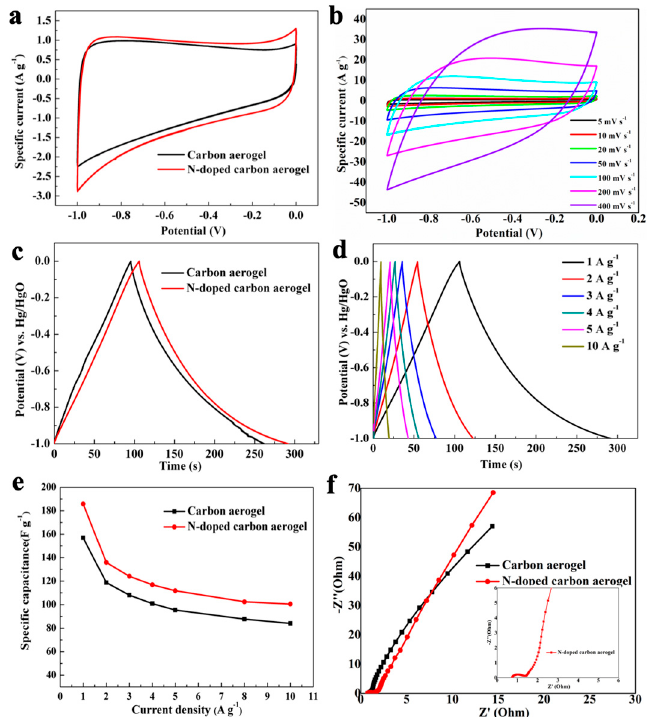
Figure 5. Electrochemical capacitive behaviors of the carbon aerogel and N-doped carbon aerogel. ( a ) CV curves at a scan of 10 mV s − 1 (6 M KOH); ( b ) CV curves of the N-doped carbon aerogel at different scan rates; ( c ) galvanostatic charge/discharge curves of the carbon aerogel and N-doped carbon aerogel at 1 A g − 1 ; ( d ) galvanostatic charge/discharge curves of the N-doped carbon aerogel with different current densities; ( e ) specific capacitances of the carbon aerogel and N-doped carbon aerogel at different current densities; ( f ) Nyquist plots of the carbon aerogel and N-doped carbon aerogel.